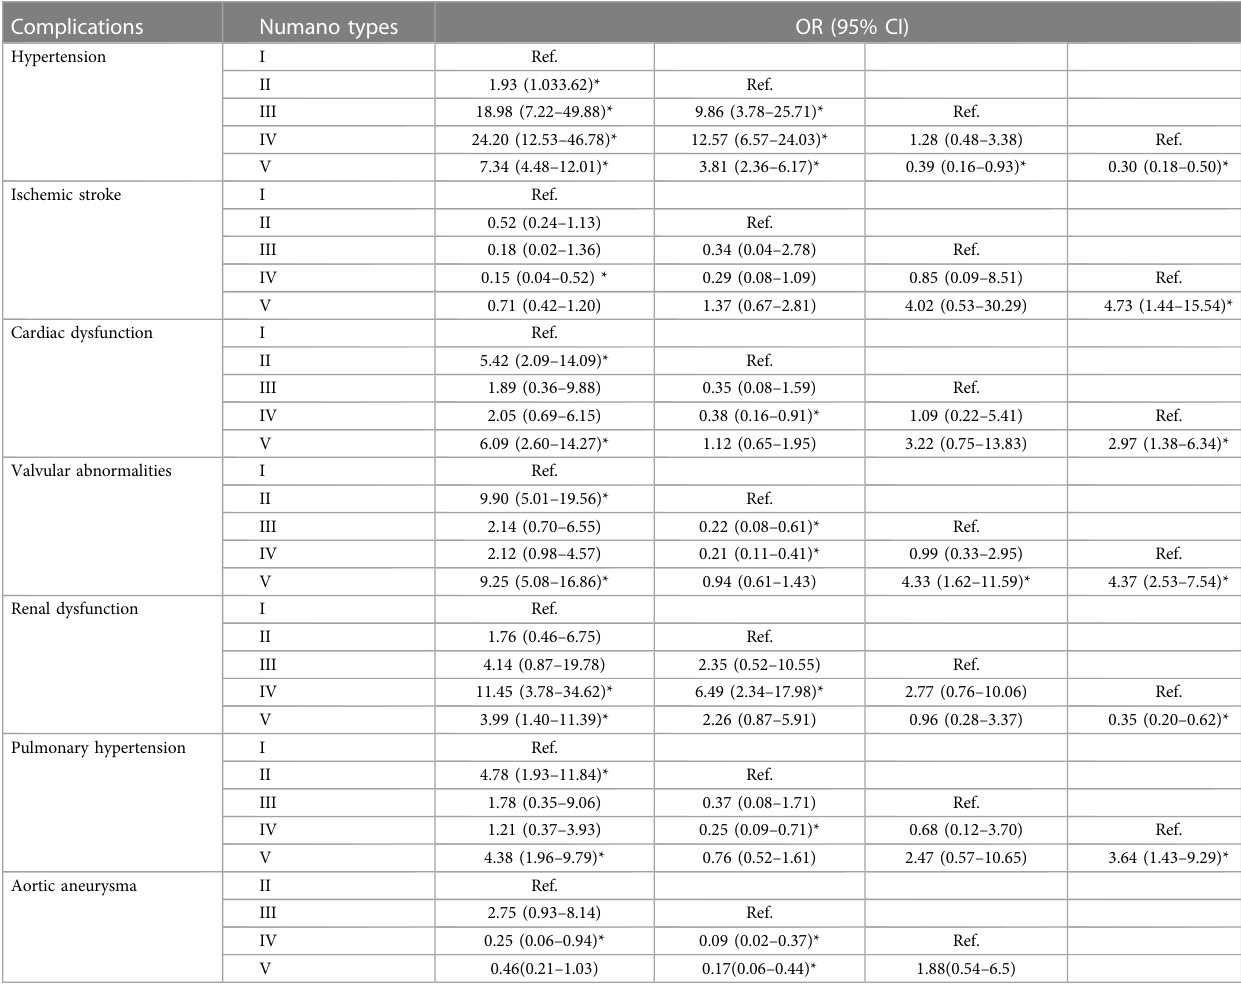
TABLE 4 Association between the different numano types and complications among Chinese TAK patients after adjusting for age at onset and